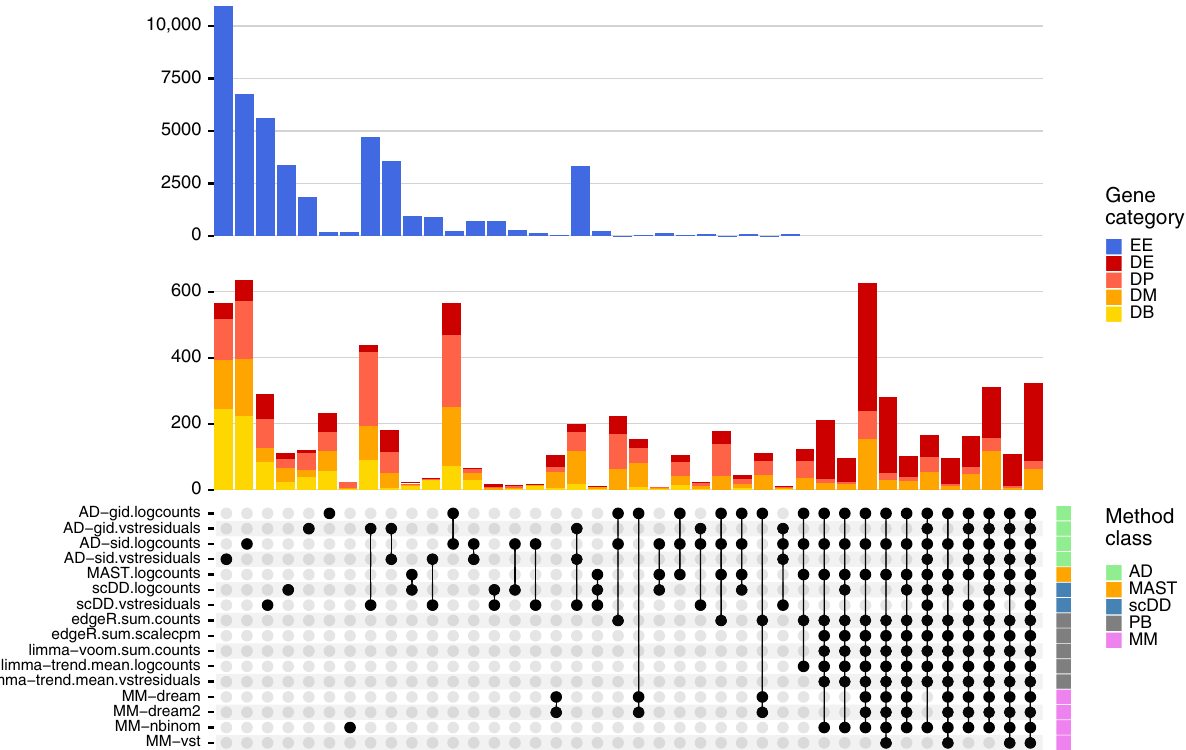
Fig. 3 Between-method concordance. Upset plot obtained from intersecting the top- n ranked gene-subpopulation combinations (lowest p value) across methods and simulation replicates. Here, n = min( n 1 , n 2 ), where n 1 = number of genes simulated to be differential, and n 2 = number of genes called differential at FDR < 0.05. Shown are the 40 most frequent interactions; coloring corresponds to (true) simulated gene categories. The bottom right annotation indicates method types (PB pseudobulk (aggregation-based) methods, MM mixed models, and AD Anderson – Darling